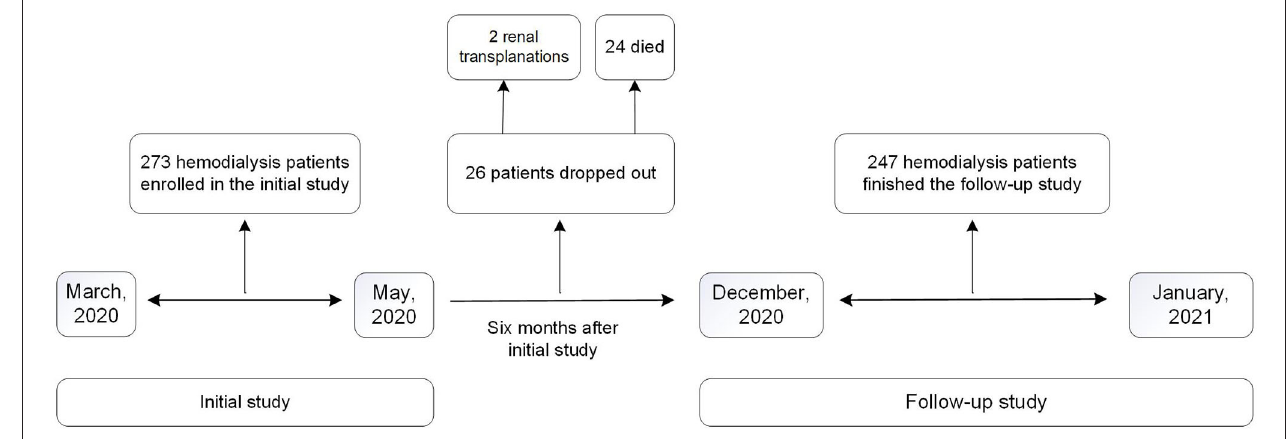
FIGURE 1 | Flow diagram of study design.